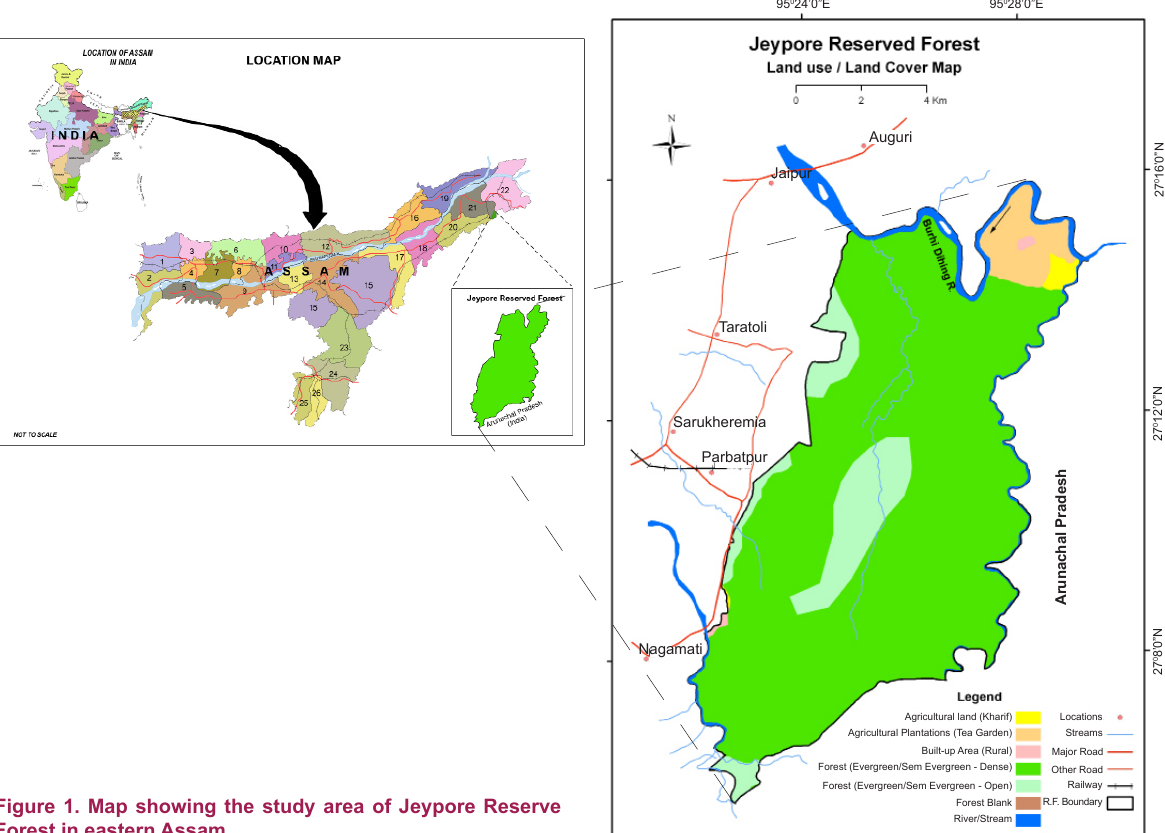
Figure 1. Map showing the study area of Jeypore Reserve Forest in eastern